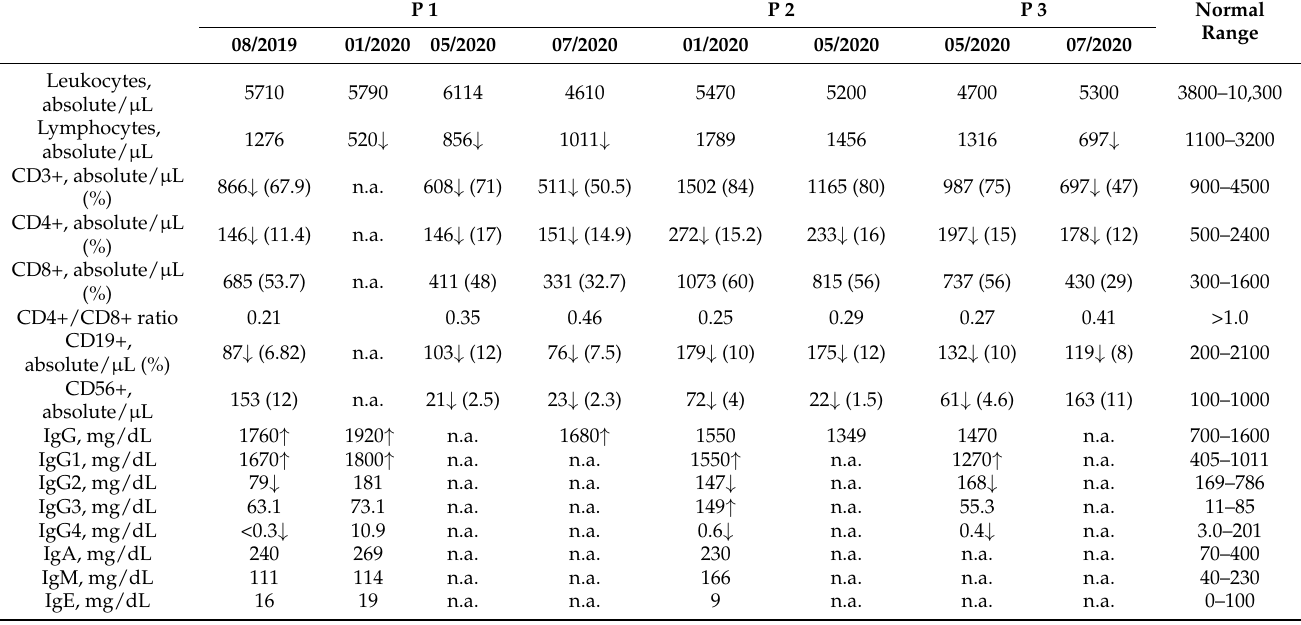
Table 2. General immunological characterization of the affected